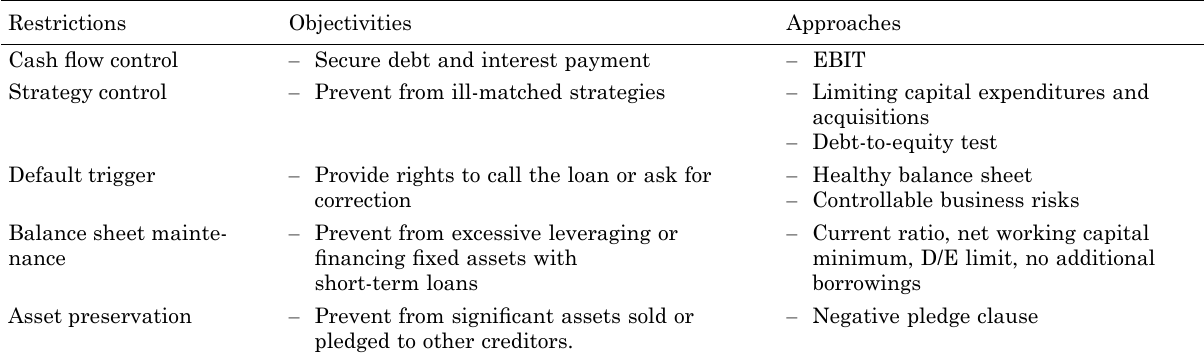
Table 3. The objectivities and approaches for loan covenants